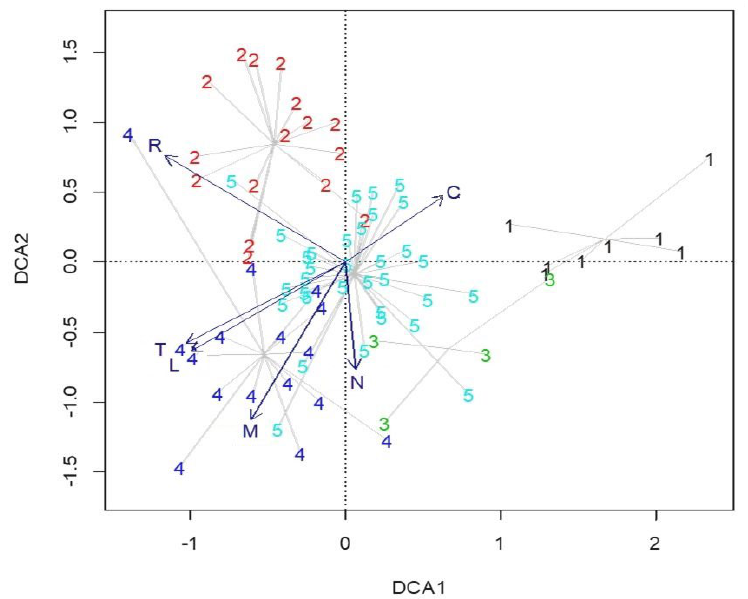
Figure 8. Ordination plot of DCA analysis with weighted Ellenberg indicator values passively projected as vectors over the ordination of TWINSPAN groups (C—continentality, L—light, M—moisture, N—nutrients, R—reaction, T—temperature).